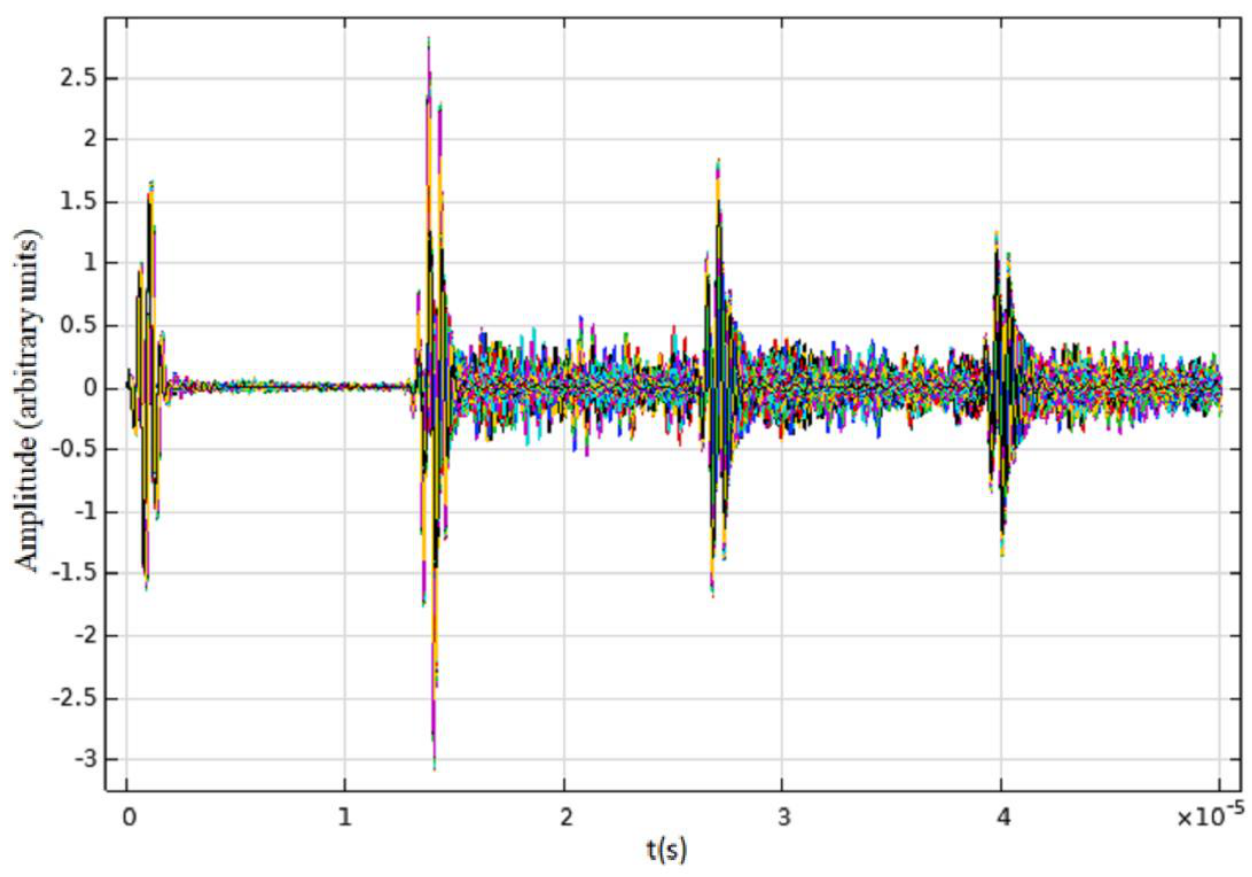
Figure 8. RF signals obtained from COMSOL ® corresponding to the domain expressed in Figure 4. The first signal is the emitted pulse, and the others are received echoes.